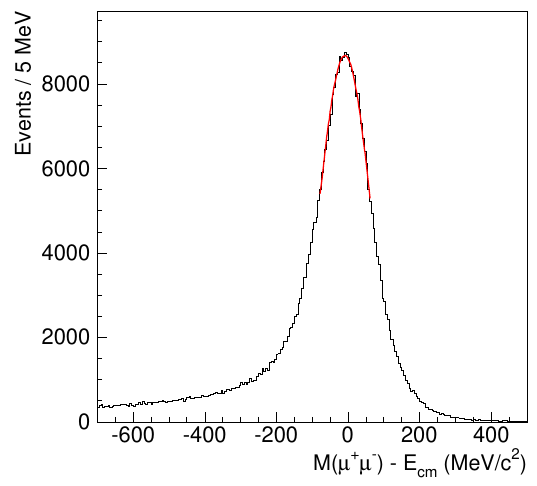
Figure 2 . M ( (cid:22) + (cid:22) (cid:0) ) (cid:0) E c : m : distribution for selected e + e (cid:0) ! (cid:22) + (cid:22) (cid:0) candidates in the scan data sample. Red curve is the (cid:12)t